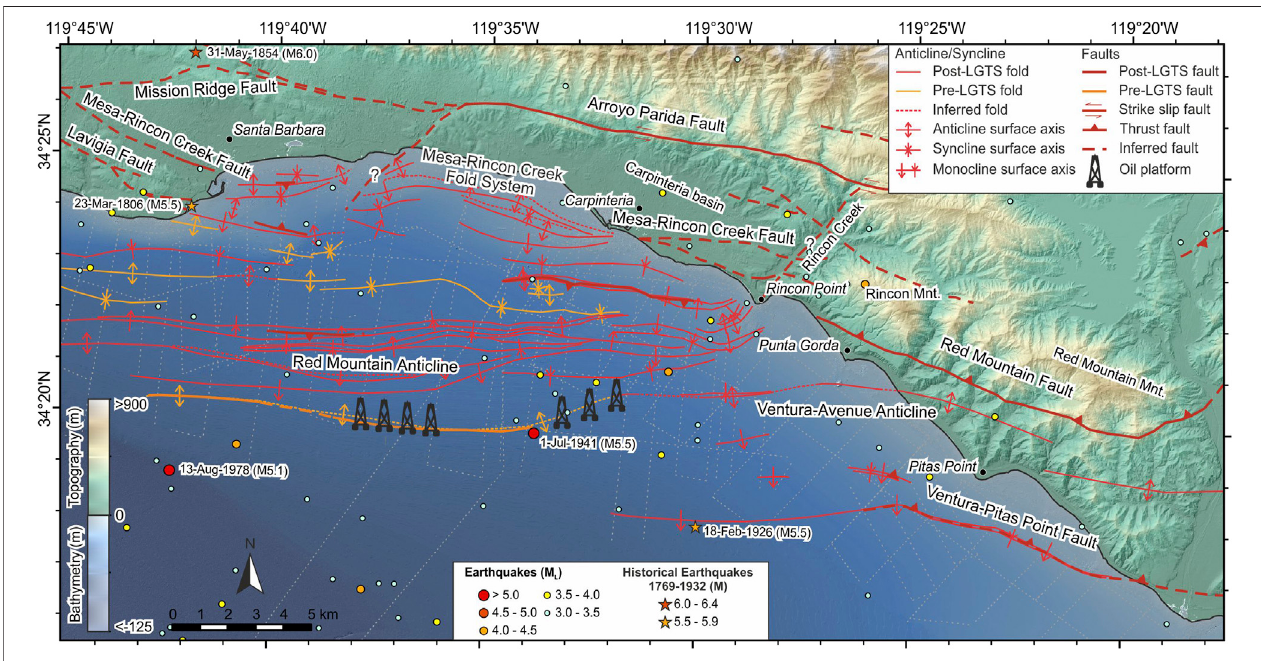
FIGURE 10 | Tectonic map of the offshore region between Ventura and Santa Barbara showing the location of faults, anticlines and synclines interpreted and correlated between the high-resolution seismic pro fi les (white dotted lines) and their projected correlation with the onshore active faults (Jennings and Bryant, 2010). Note the different colorbetweenthe foldsaffectingtheLast Glacial transgressive surface and Holocene unit (in red)and the Mio-Pleistocene units(in orange). Apotential step over tothe north isobserved between the Lavigia and Mesa-RinconCreek faults mapped inSantaBarbararegion and their location offshore ofCarpinteria as shown by a fault branching off the Arroyo Parida fault. The location of this Figure is shown in Figure 1 .